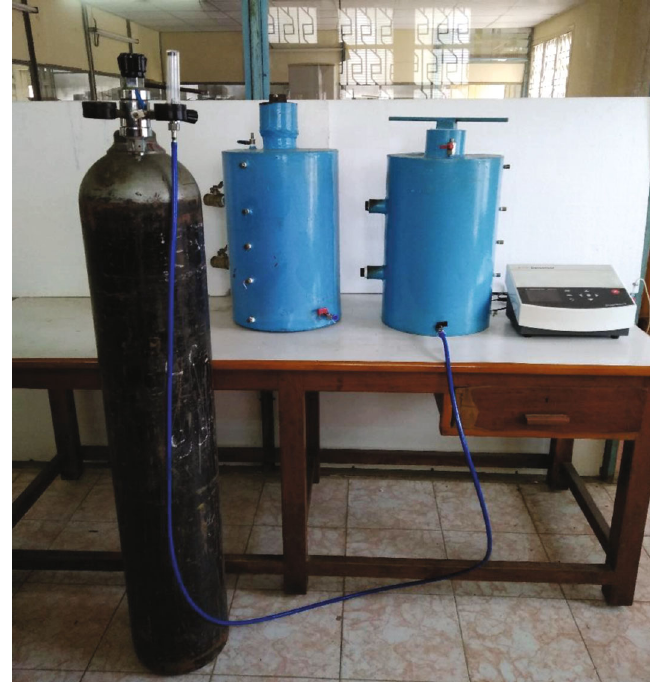
Figure 2: A view of pilot bins for CA treatments.